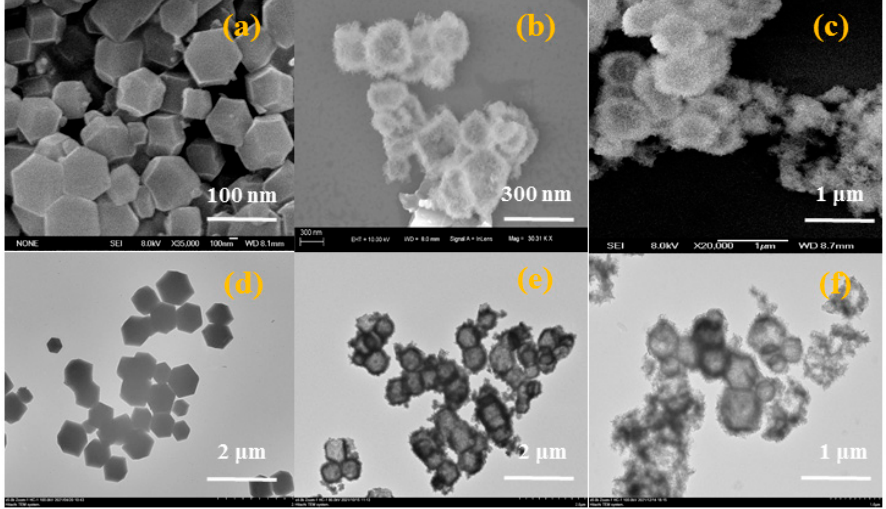
Figure 4. SEM and TEM images of ZIF-67 ( a , d ),NiCo-LDH ( b , e ) and NiCo-LDH/MoS 2 ( c , f ). Figure S1 gives the EDS spectrum and plan scan image of NiCo-LDH/MoS 2 . It can be